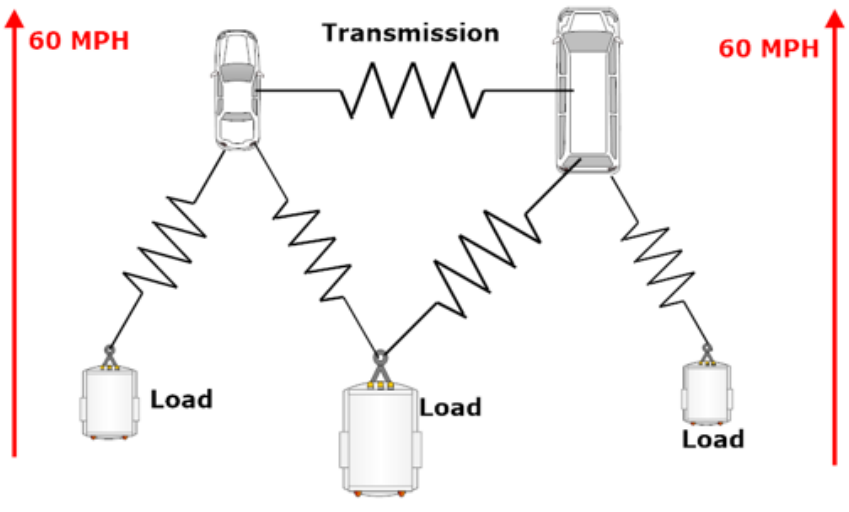
Figure 1. A mechanical